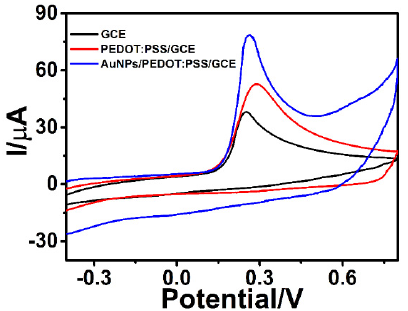
Figure 3. CV of the bare GCE, PEDOT:PSS-modified GCE, and AuNP/PEDOT:PSS-modified GCE in 0.01 M PBS (pH 9.0) containing 0.1 mM 1-naphtol.